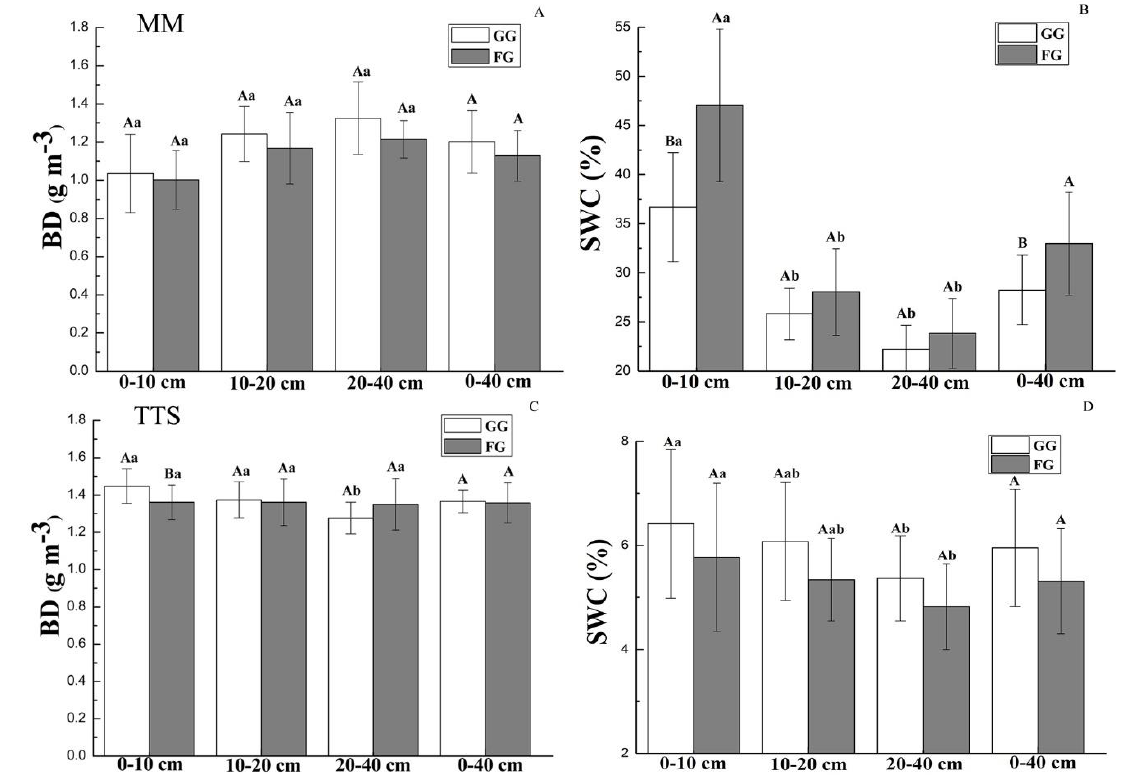
Figure 2. Soil physical properties in the MM and TTS under the grazing and fencing treatments. ( A ): Soil bulk density in MM; ( B ): Soil water content in MM; ( C ): Soil bulk density in TTS; ( D ): Soil water content in TTS. Values are the means ± standard deviation, the bar charts marked with different letters on the top of the column (Different lowercase letters for different soil layers, and different capital letters for different treatments) are significantly different ( p < 0.05). MM: mountain meadow; TTS: temperate typical steppe; GG: grazed grassland; FG: fenced grassland. BD: bulk density; and SWC: soil water content.